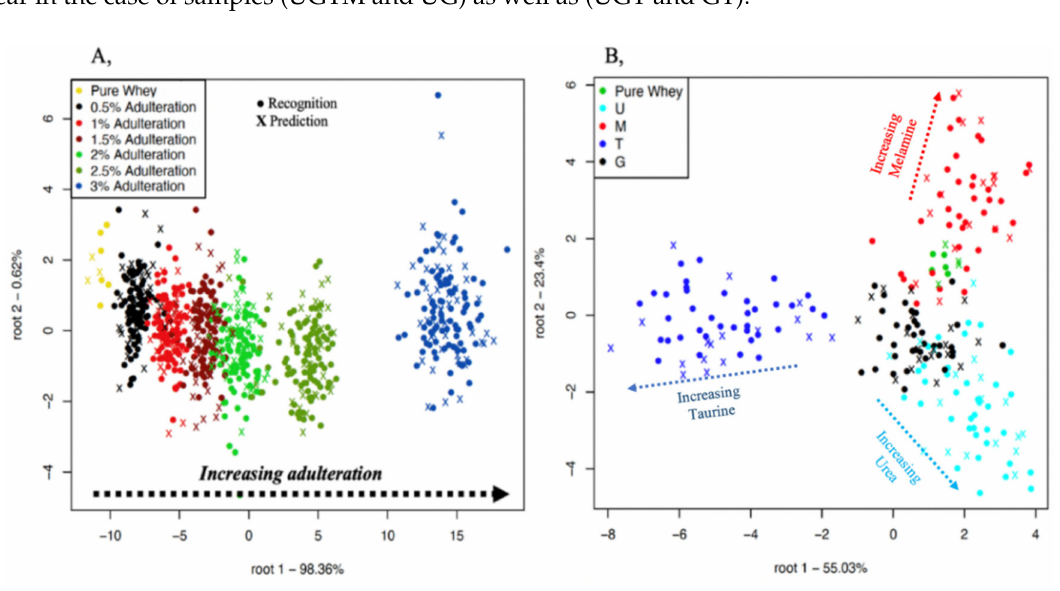
Figure 2. Classification plots of the benchtop spectrometer for adulterant concentration levels ( A ) using the entire dataset and single mixture combinations ( B ) using the data of samples containing single adulterants and pure whey protein powder. U = urea, G = glycine, T = taurine, M = melamine. Spectral pre-processing: Savitzky-Golay smoothing (second order polynomial).